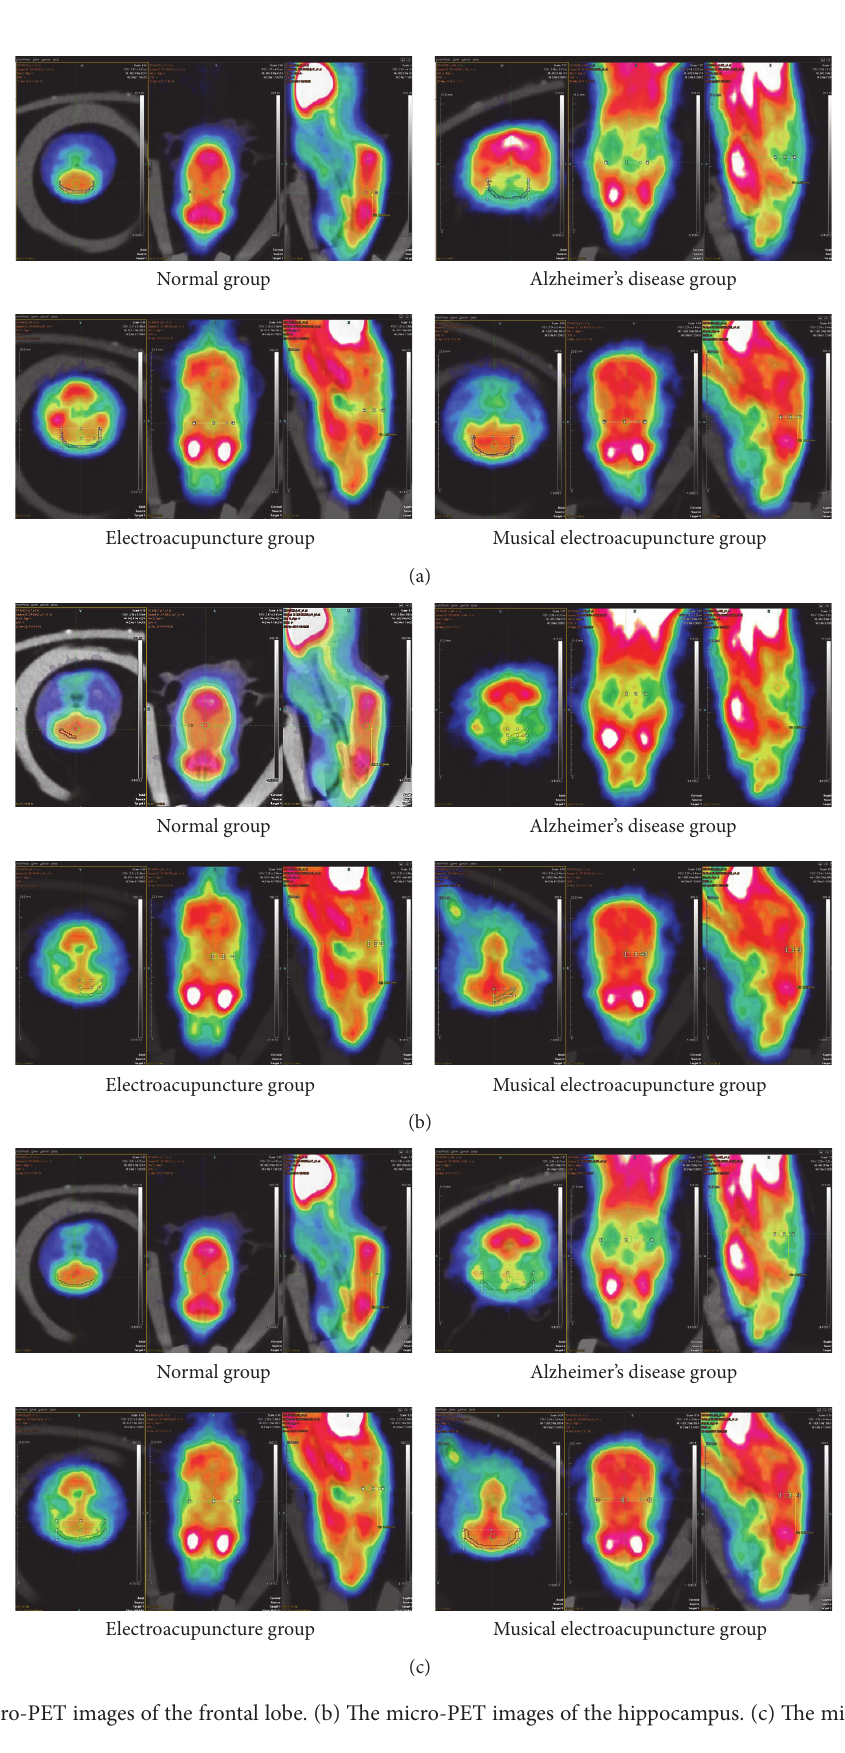
Figure 4: (a) The micro-PET images of the frontal lobe. (b) The micro-PET images of the hippocampus. (c) The micro-PET images of the cerebral